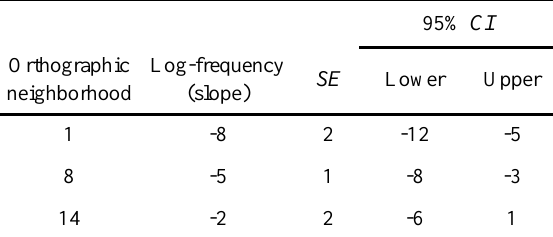
Table A2. First-fixation duration: Interaction of lexical frequency and orthographic-neighborhood size.